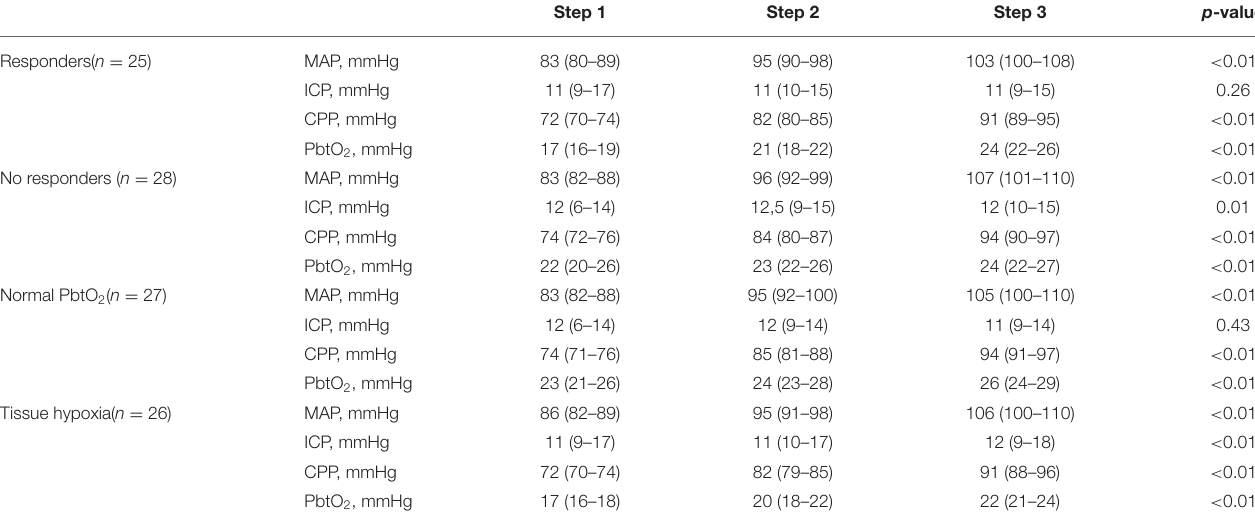
TABLE 4 | Changes in study variables on the first day of assessment, according to response to CPP challenge and baseline tissue hypoxia. Step 1 Step 2